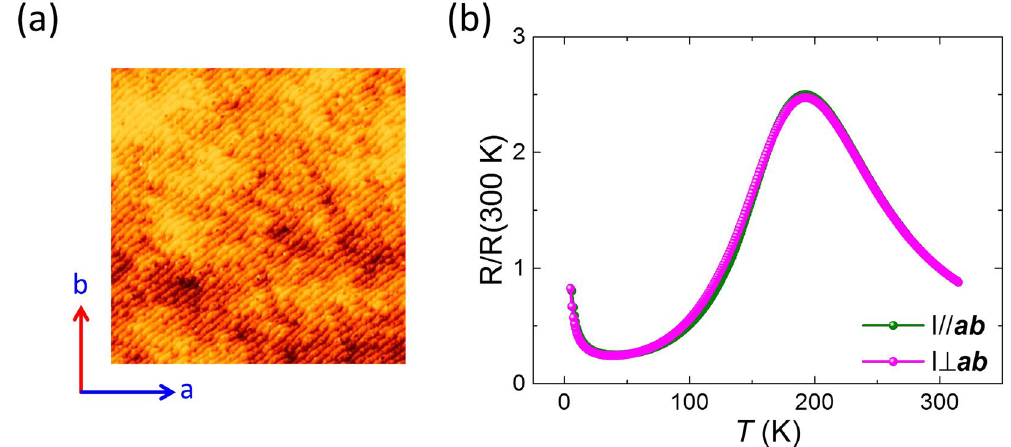
Figure 2. ( a ) Surface morphology of the 7 uc LSMO by AFM. ( b ) Resistivities of 7 uc LSMO film with current parallel or perpendicular diagonal direction ab (I// ab vs. I ⊥ ab ).